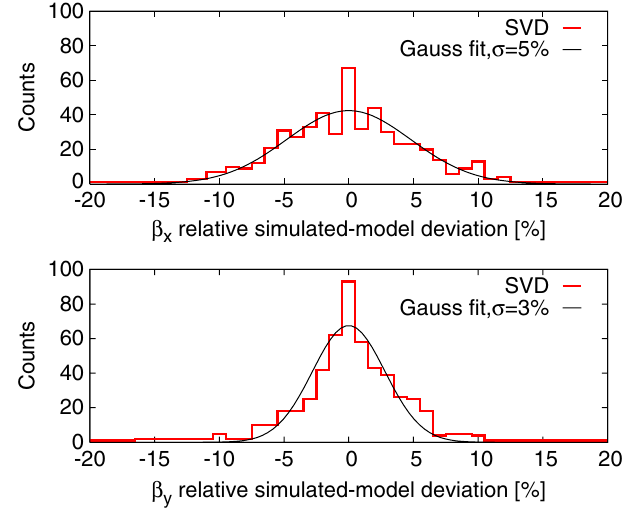
FIG. 12. (Color) Relative deviation of measured and model beta functions as obtained from